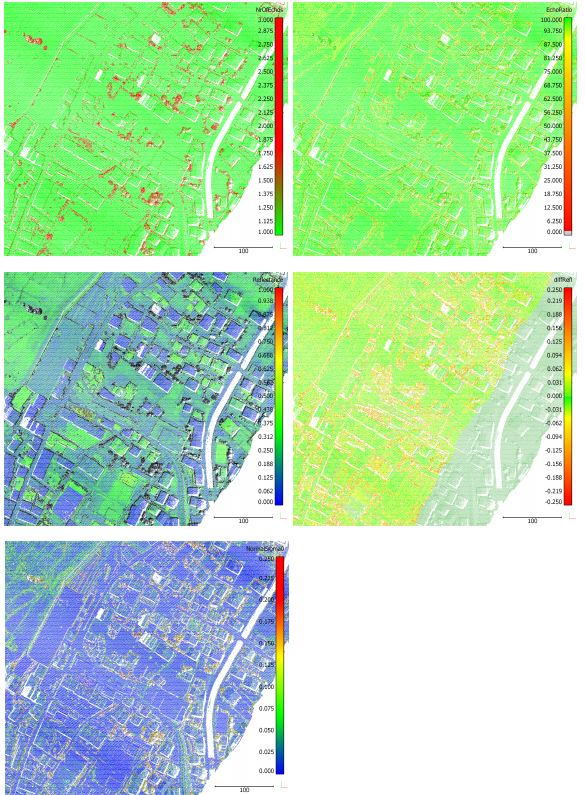
Figure 7: Criteria parameters in the town center of Zermatt (map view): Number of echoes (top left), Echo Ratio (top right), Re- flectance value (center left), absolute difference of reflectance values (center right), σ 0 of normal vector estimation